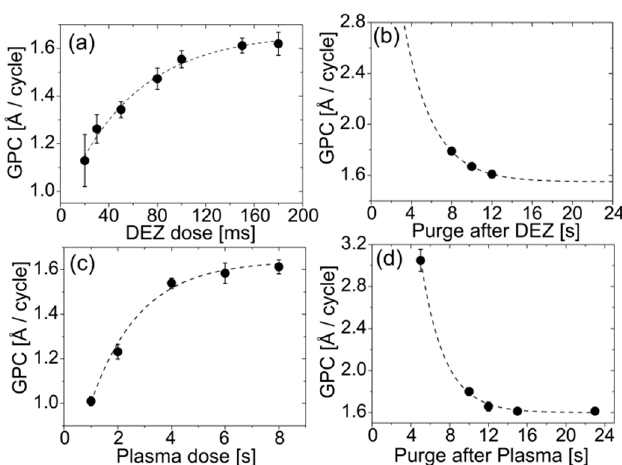
Figure 1. Saturation curves (growth per cycle vs. doses and purging) for the four steps of a PE-ALD cycle: ( a ) DEZ dose, ( b ) purge after DEZ, ( c ) plasma dose, and ( d ) purge after